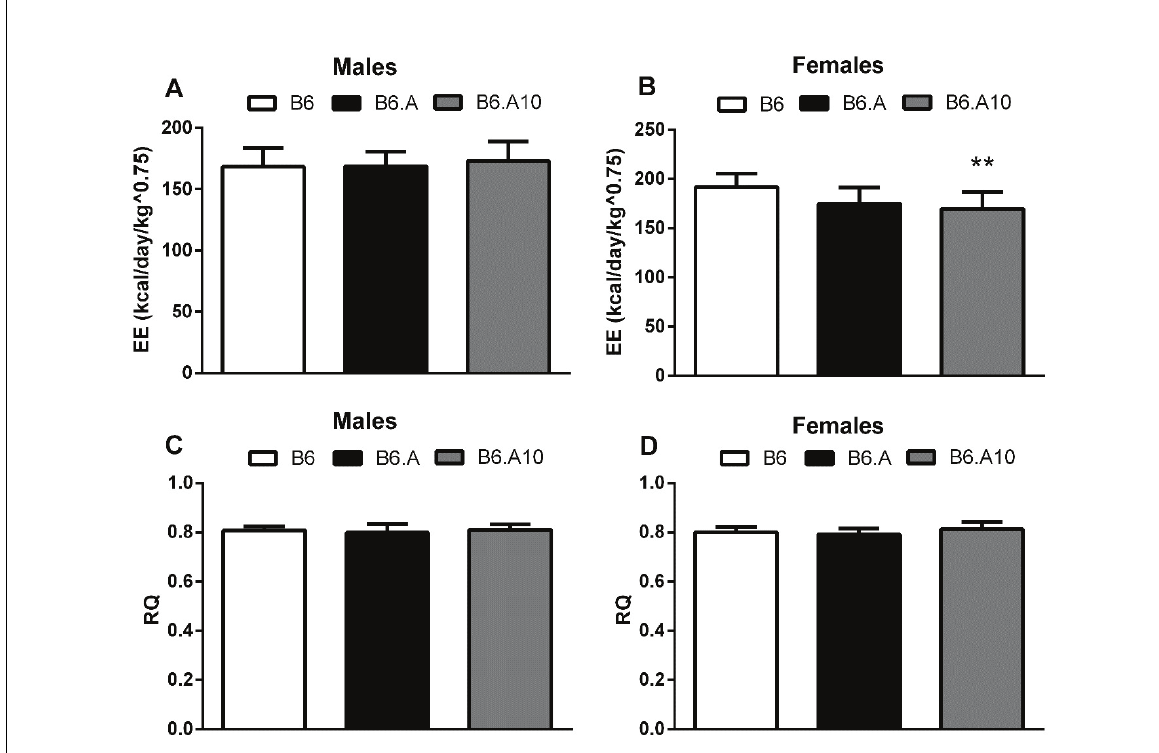
Figure 1. Strain effect on energy expenditure (A, B) and respiratory quotient (C, D) in B6, B6.A and B6.A10 male and female mice